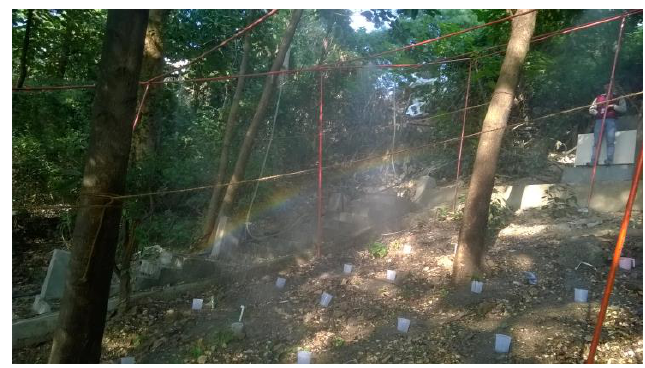
Figure 4. Rainfall experiment for calculation of coefficient of uniformity.